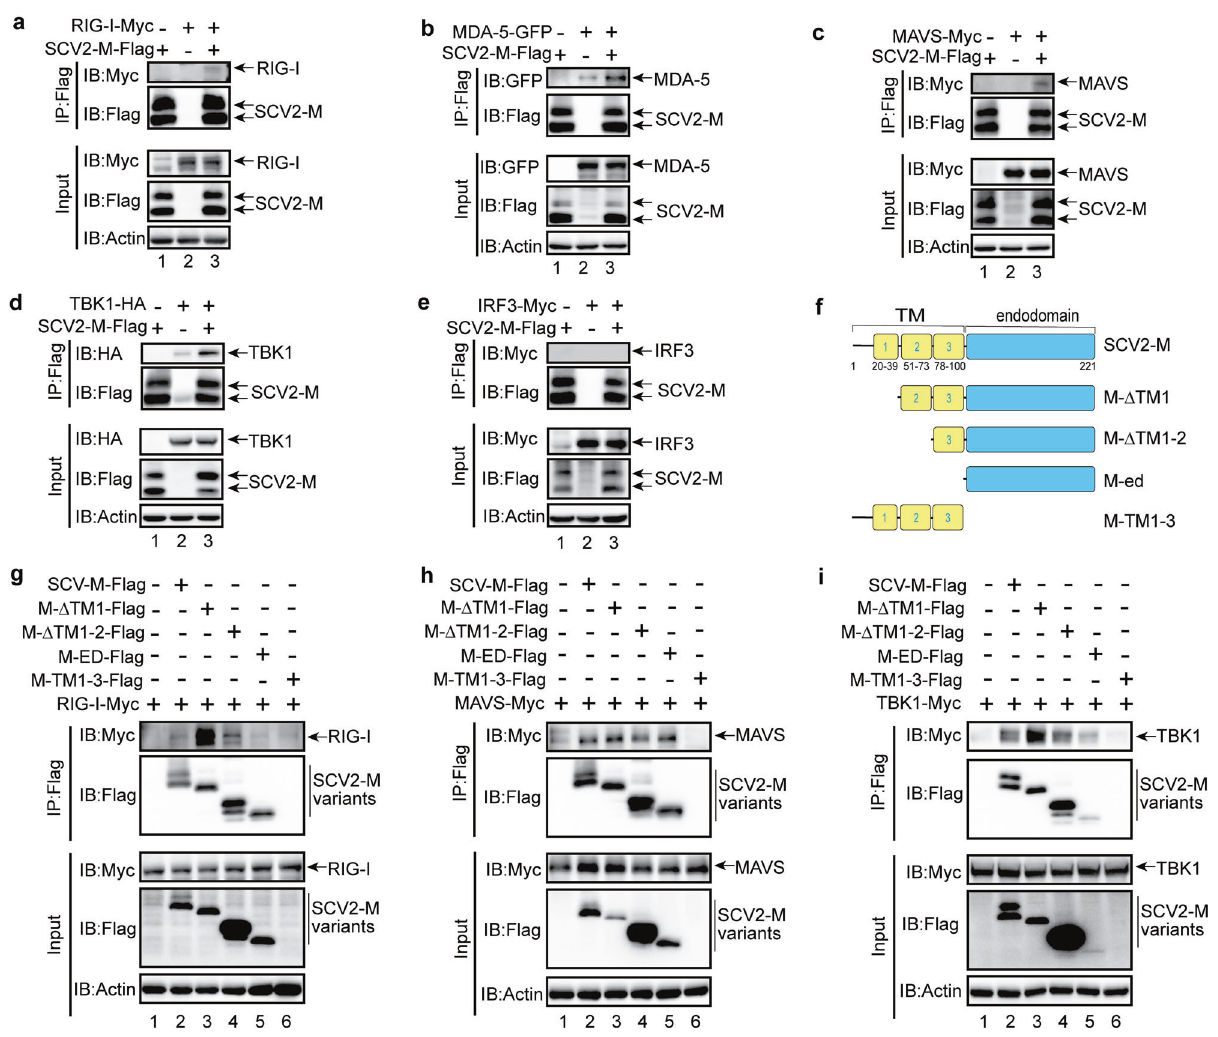
Fig. 4 The SARS-CoV-2 M protein interacts with RIG-I ( a ), MDA-5 ( b ), MAVS ( c ), and TBK1 ( d ) but not with IRF3 ( e ). f The truncated variants of SARS-CoV-2 M protein are depicted. g – i The interaction of RIG-I, MAVS, and TBK1 with the truncated variants of SARS-CoV-2 M protein. The HEK293T cells were transfected with the indicated plasmids for 24 h before coimmunoprecipitation with the anti-Flag magnetic beads. The pcDNA6B empty vector was used to balance the total amount of plasmid DNA in the transfection. The input and immunoprecipitates were immunoblotted with the indicated antibodies. Immunoblotting results are representative of two independent experiments. SARS-CoV-2 M protein,